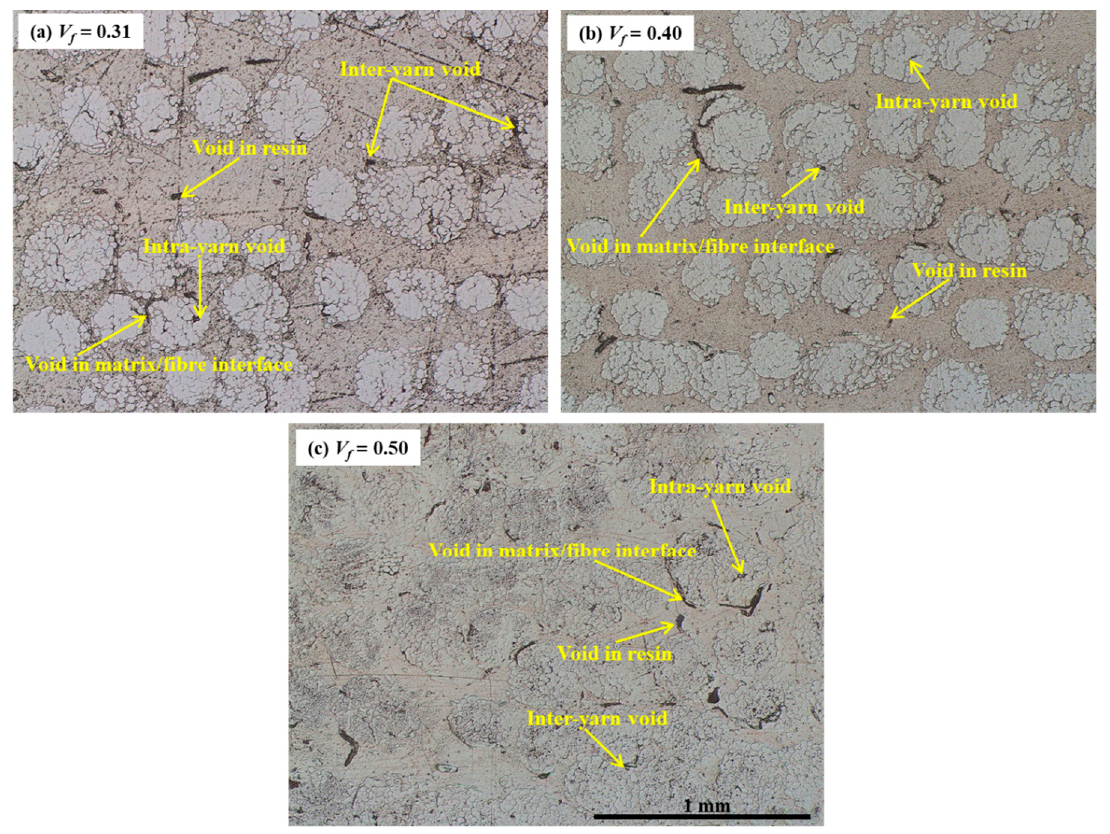
Figure 11. Micro-CT cross-section images of flax/PP composites showing the voids in the matrix and matrix/fibre interface, and the intra-yarn and inter-yarn voids.